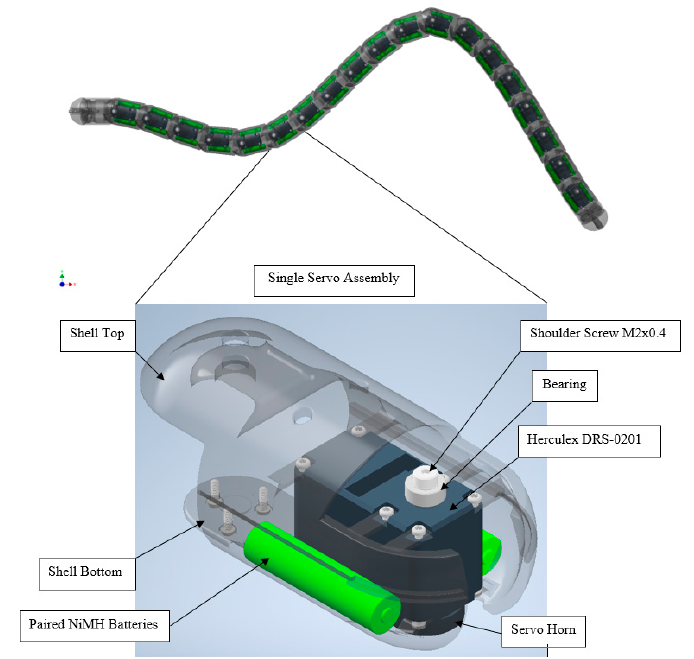
Figure 3. Shell assembly of the segment showing the servo motor, the shell, the batteries (wiring not shown) and other miscellaneous components.